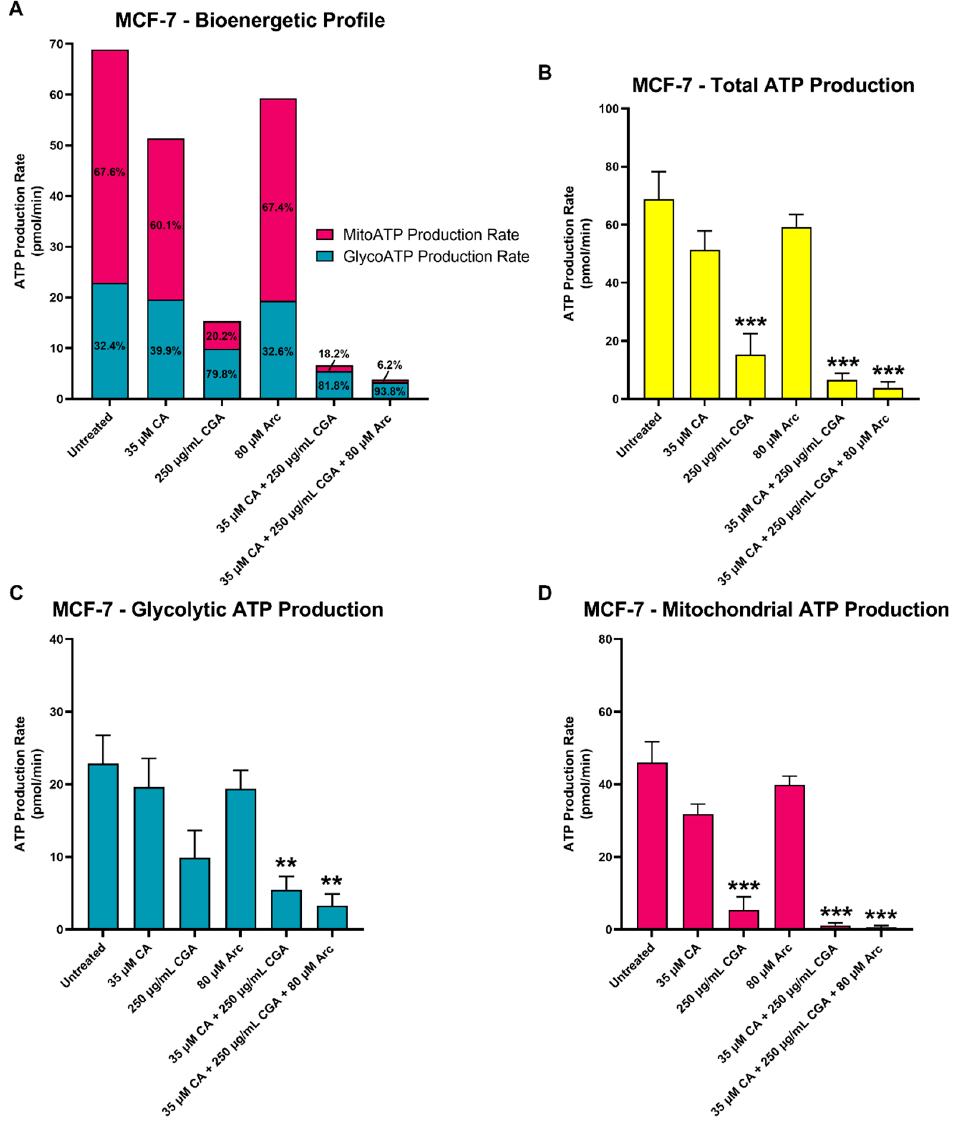
Figure 12. Bioenergetic profile and total, glycolytic, and mitochondrial ATP production in MCF-7 breast cancer cells treated with 35 μ M CA, 250 μ g/mL CGA, and 80 μ M Arc, for 48 h. ( A ) Each bar represents the mean of mean ATP production rate (pmol/min) values from 3 biological and 4 experimental replicates ( n = 4). Percentages denote the proportion of the total ATP production rate gen-